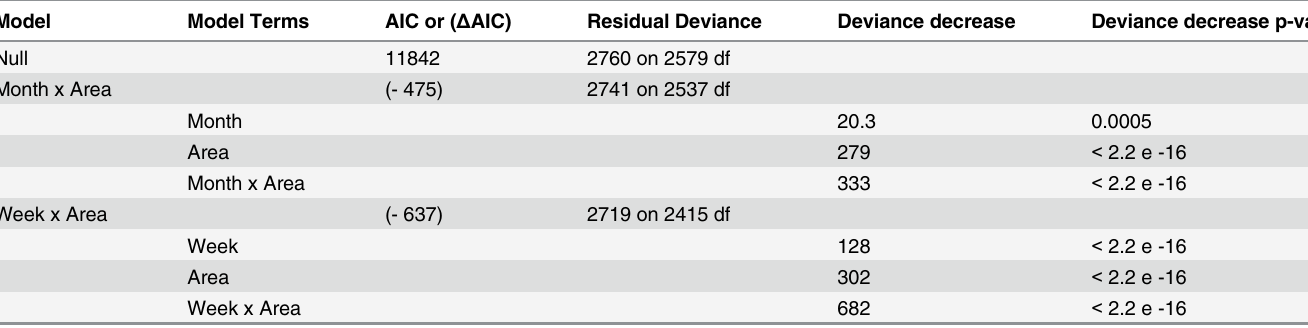
Table 5. Models of catch per unit effort.